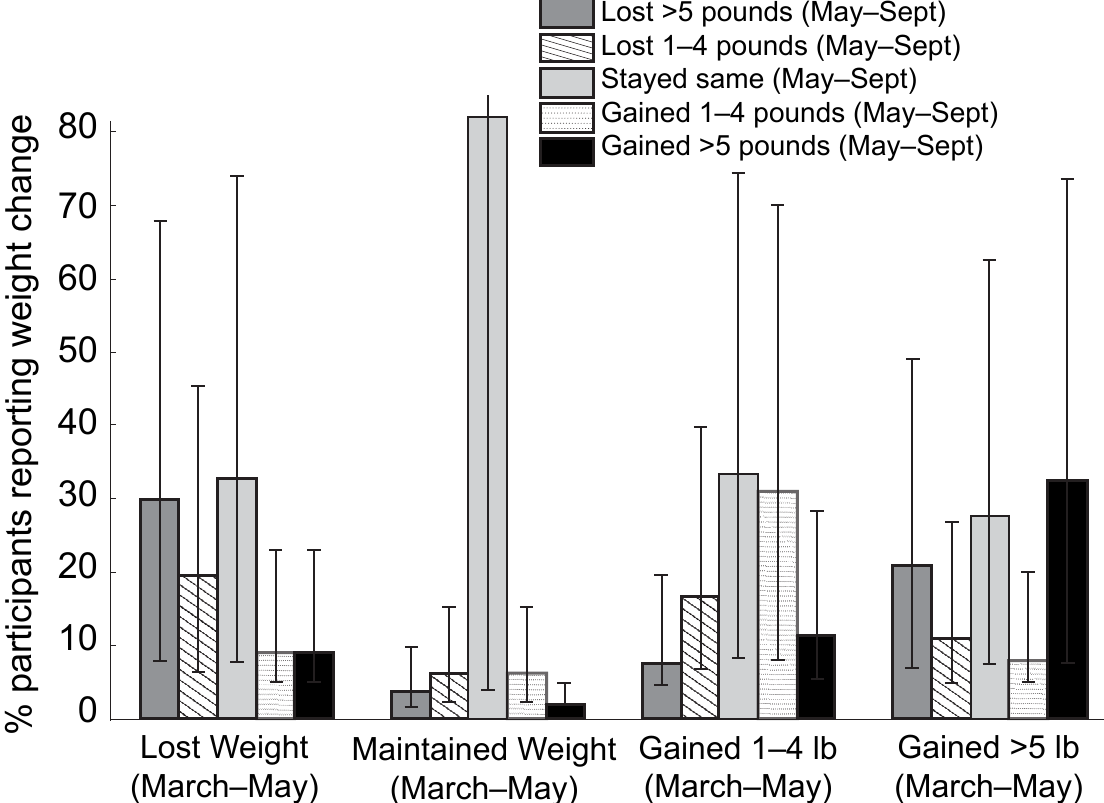
Figure 2. Weight change during the post-lockdown (May-September) in participants who reported to have gained, lost, or maintained body weight during the peak-lockdown period (March through May). Error bars represent 95% Confidence